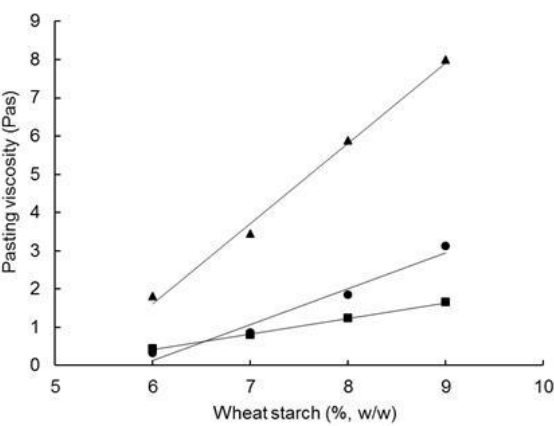
Figure 5. Influence of starch content on the viscosity of a wheat starch suspension after different times during pasting: after heating to 95 °C over 10 min, V 95 ( ); holding at 95 °C for 25 min, V h ( ); and cooling to 30 °C, V c ( ).